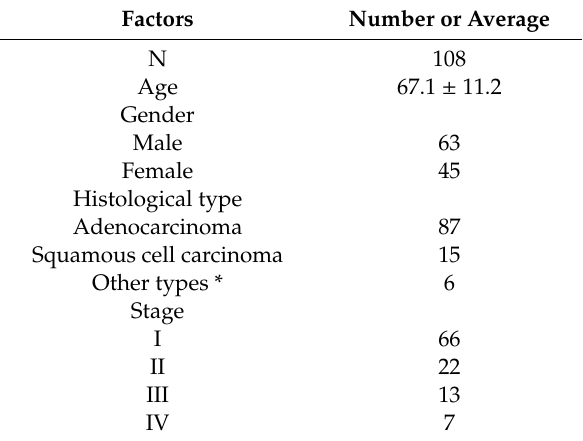
Figure 4. Kaplan–Meier survival curves for high CAR / DSG2 gene co-expression in early stage LUAD. Table 1. Demographic data for non-small-cell lung cancer (NSCLC) cases.